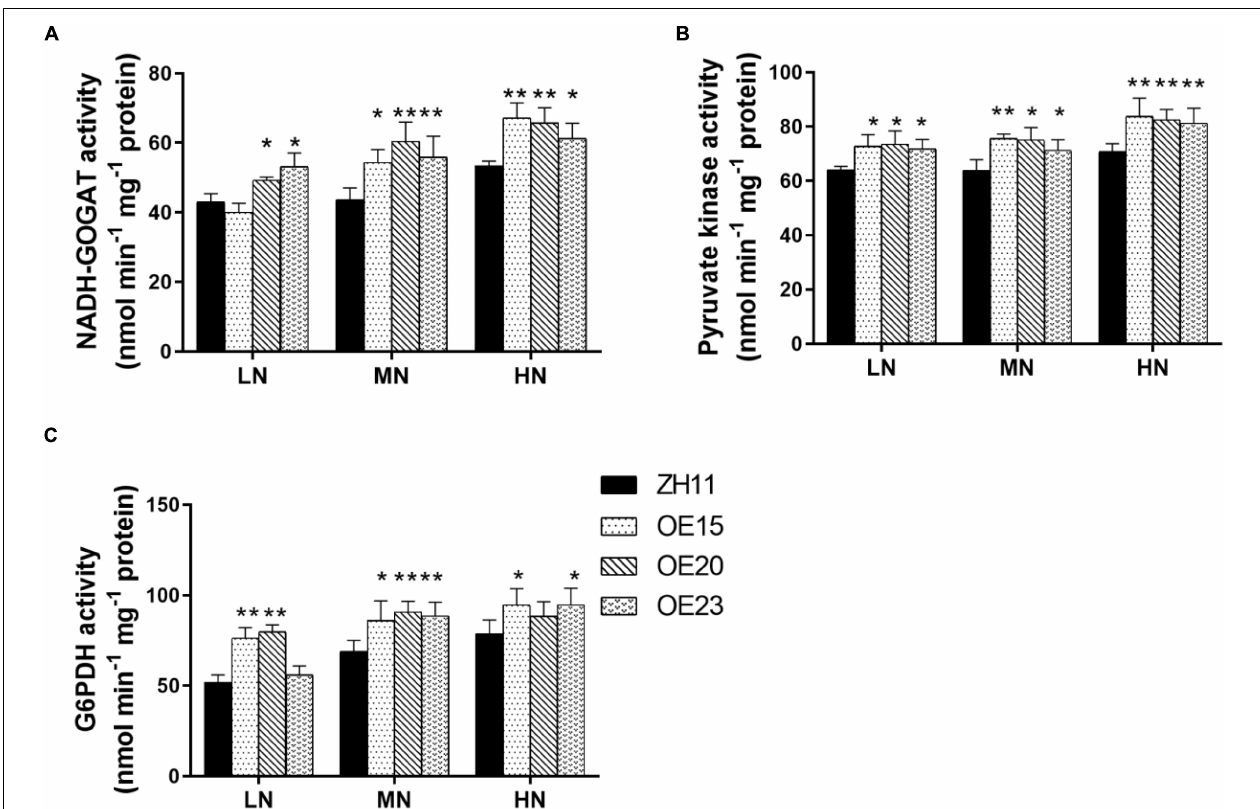
FIGURE 8 | The enzyme activities in the roots of OsMYB305 -OE (OE15, OE20, OE23) and WT (ZH11) under different N treatments. Values were means ± SD of 3 biological replications. Statistical significance was determined by Student’s t -test (* P < 0.05, ** P <